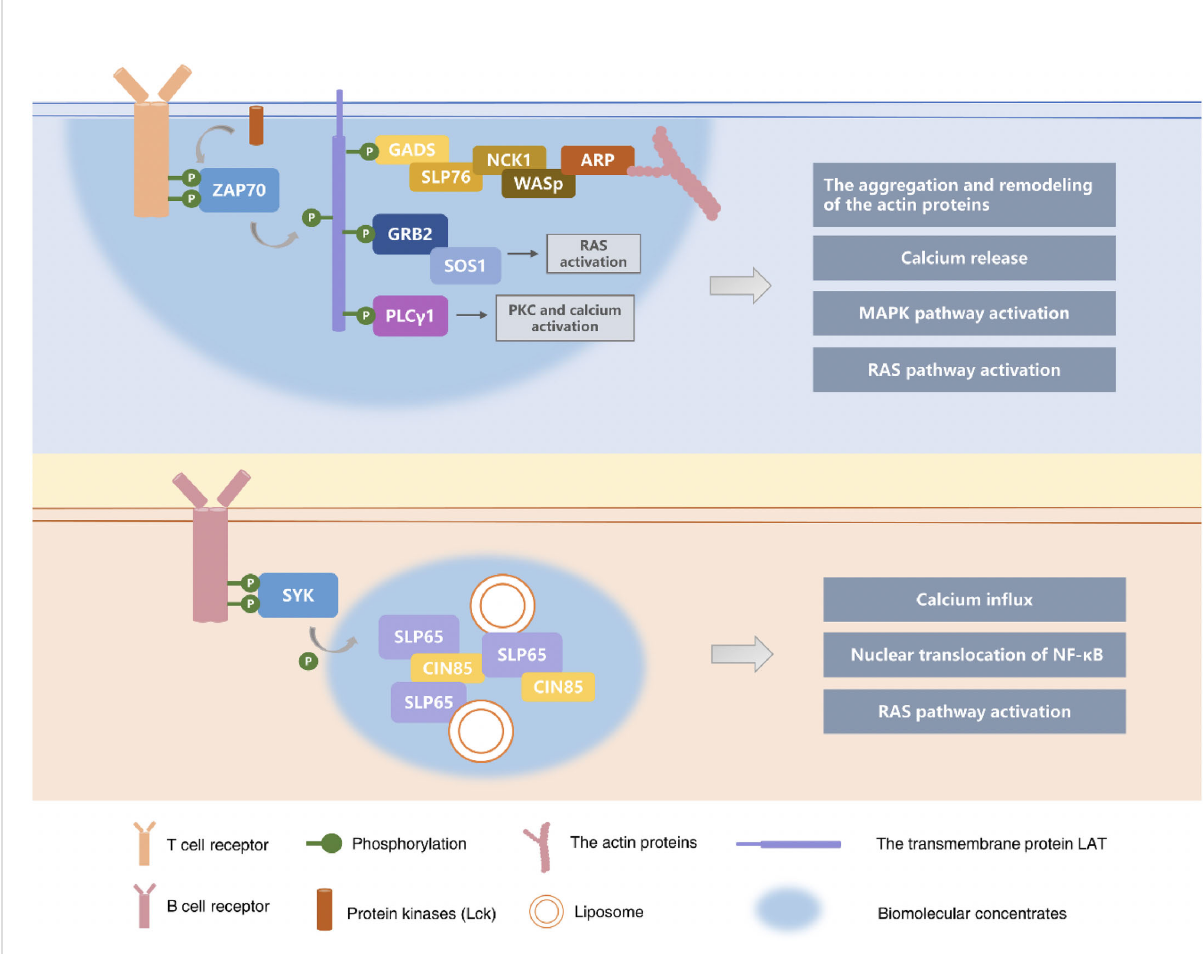
FIGURE 2 Phase separation in adaptive immune responses. In the adaptive immune response following activation of T cells and B cells, receptors and downstream signal molecules on the surface of immune cells will form condensates supported by the phase separation, amplifying the immune cascade signal. The key component used to activate T cells during TCR signaling is a transmembrane protein LAT (linker), which forms biomolecular condensates with GRB2 and SOS1 by the phase separation. The signal clusters in biomolecular condensates continue to recruit and phosphorylate the adaptive proteins (e.g., GRB2, GADS, and SLP76) to activate the effector proteins at the end of signaling (e.g., SOS1, PLC g 1, Nck, WASp, and ARP2/3). Ultimately the liquid condensates with LAT-GrB2-SOS1 activate T cells and their downstream cellular biological responses. (32, 121 – 124) Scaffold protein SLP65 is a key component that mediates BCR signal transduction, and it can also participate in activating B cells by phase separation. SLP65 and CIN85 have polyvalent interactions with the proline-rich motif (PRMs) of SLP65 through the nine SH3 domains of trimer CIN85, and the biophase is separated with the participation of lipid vesicles to form biomolecular condensates, which in turn trigger downstream biological responses in B cells, such as mobilization of second messenger Ca 2+ and nuclear translocation of a key transcription factor NF- k B (34 – 36,